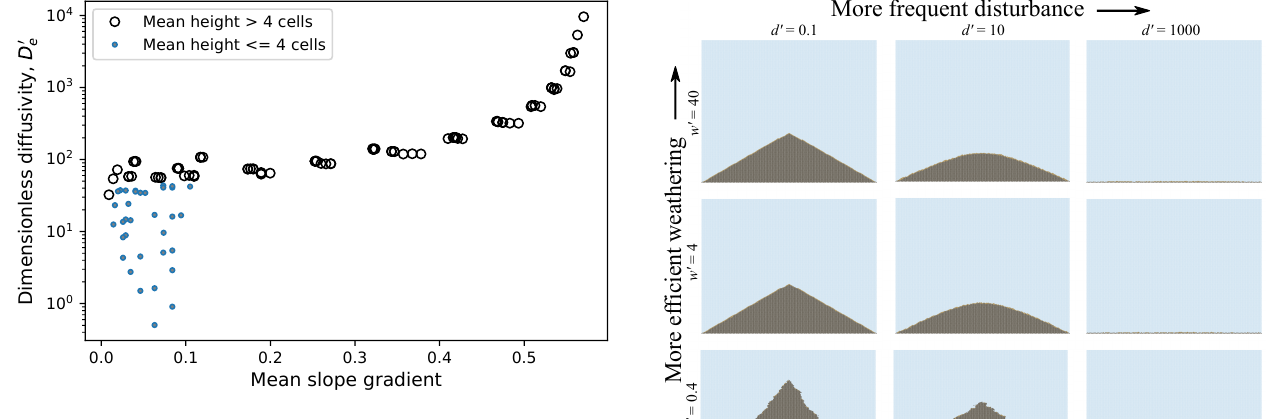
Figure 10. Relationship between dimensionless diffusivity and mean gradient, from the series of 125 model runs of which a subset is shown in Fig. 8.